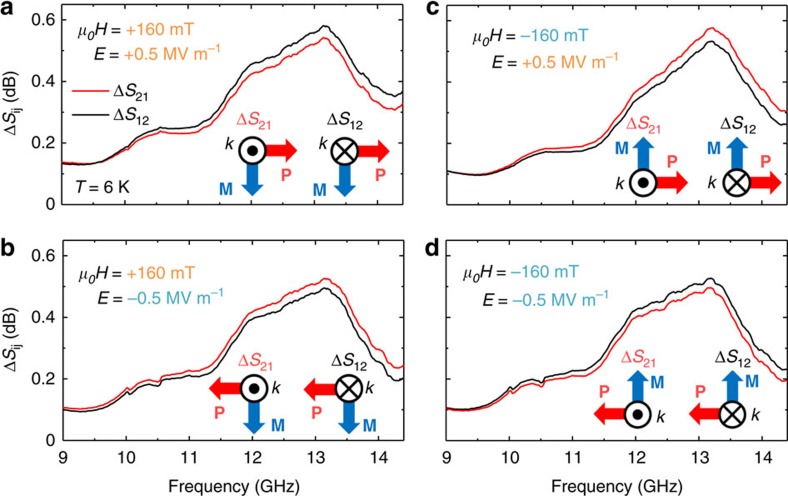
Magnetoelectrical control of microwave nonreciprocity.(a–d) Microwave absorption ΔS12, ΔS21 at 6 K in ±160 mT (+160mT in (a,b) and −160mT in (c,d)). The poling fields were E=±0.5 MV m−1 (+0.5 MVm−1 in (a,c) and −0.5 MVm−1 in (b,d)). Inset illustrates the directional relation of P, M and k for ΔS12 and ΔS21 measurements.